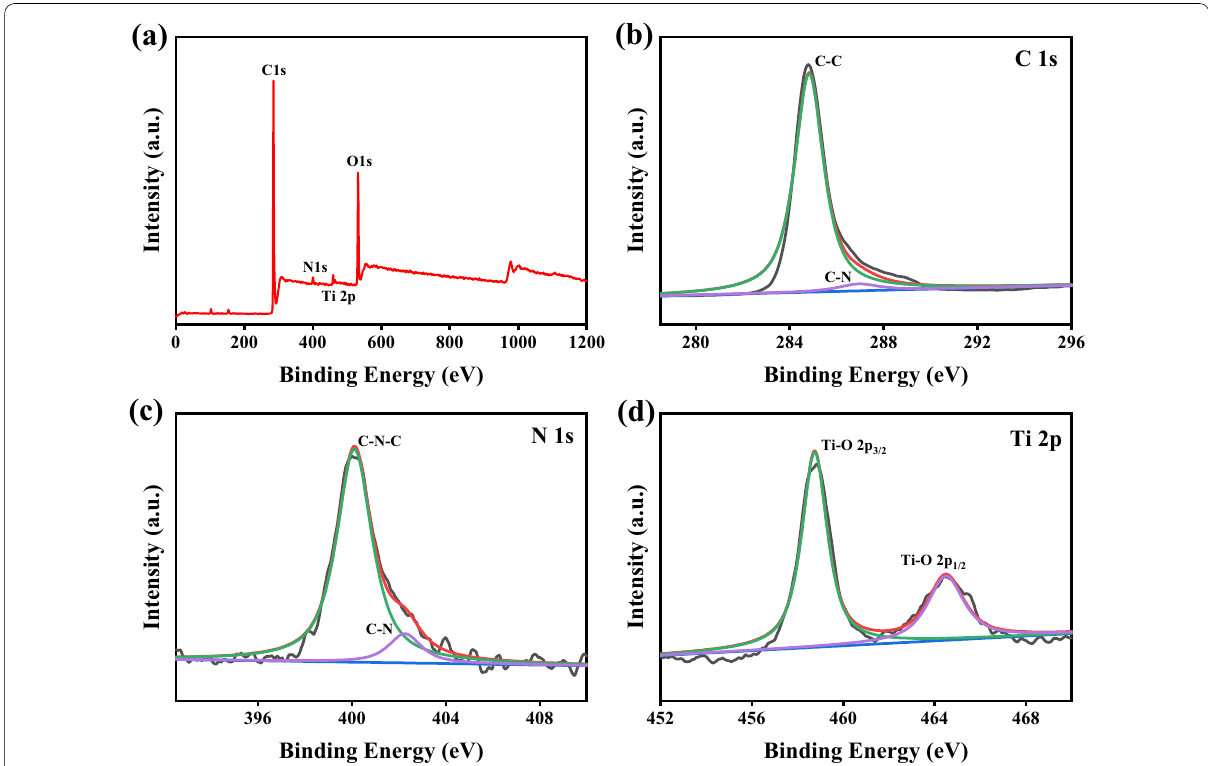
Fig. 3 a XPS survey spectrum of MQDs; high resolution, b C 1 s , c N 1 s , and d Ti 2 p XPS spectra of